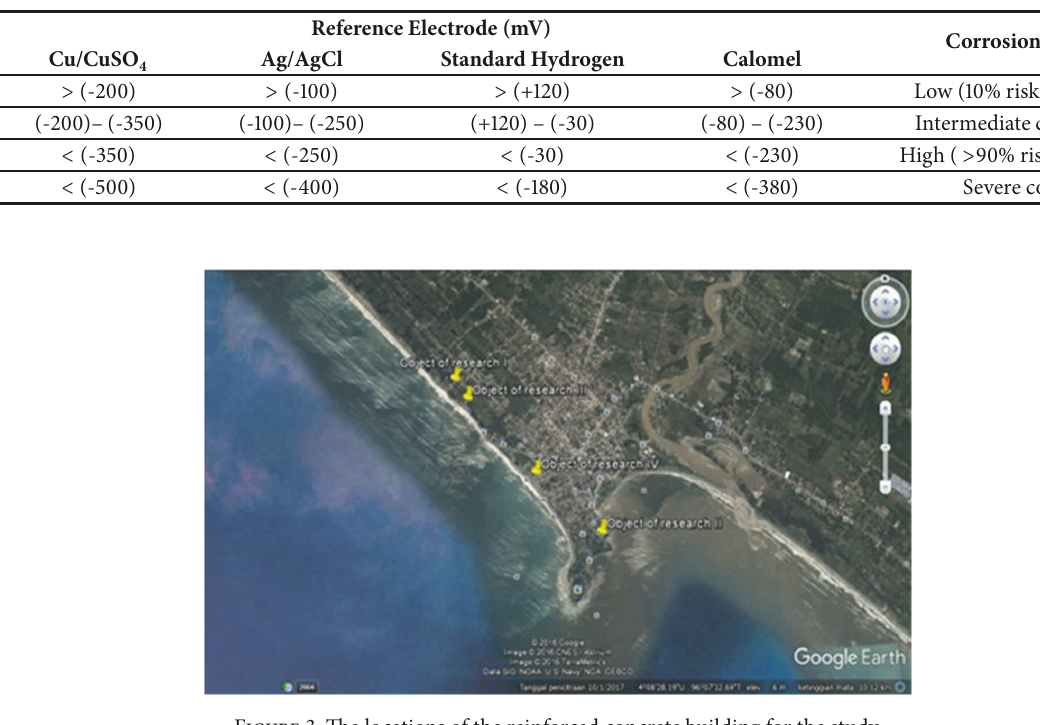
column 2, column 3, and column 4 ranged between (-100) and (-350) mV, < -200 mV, (-200) and (-350) mV, and (-100) and (- 450) mV, respectively, while those potential distributions of the columns ranged between (-200) and (-350) mV, (-200) and (-350) mV, (-200) and (-350) mV, and (-200) and (-350) mV, respectively, of year